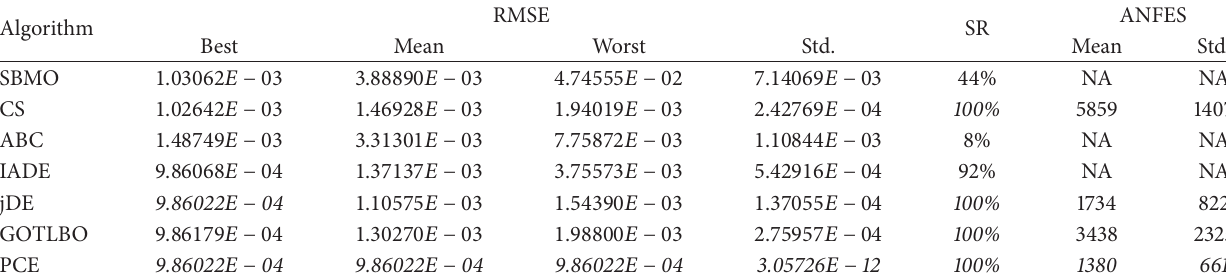
Table 9: Simulation results for the single diode model.